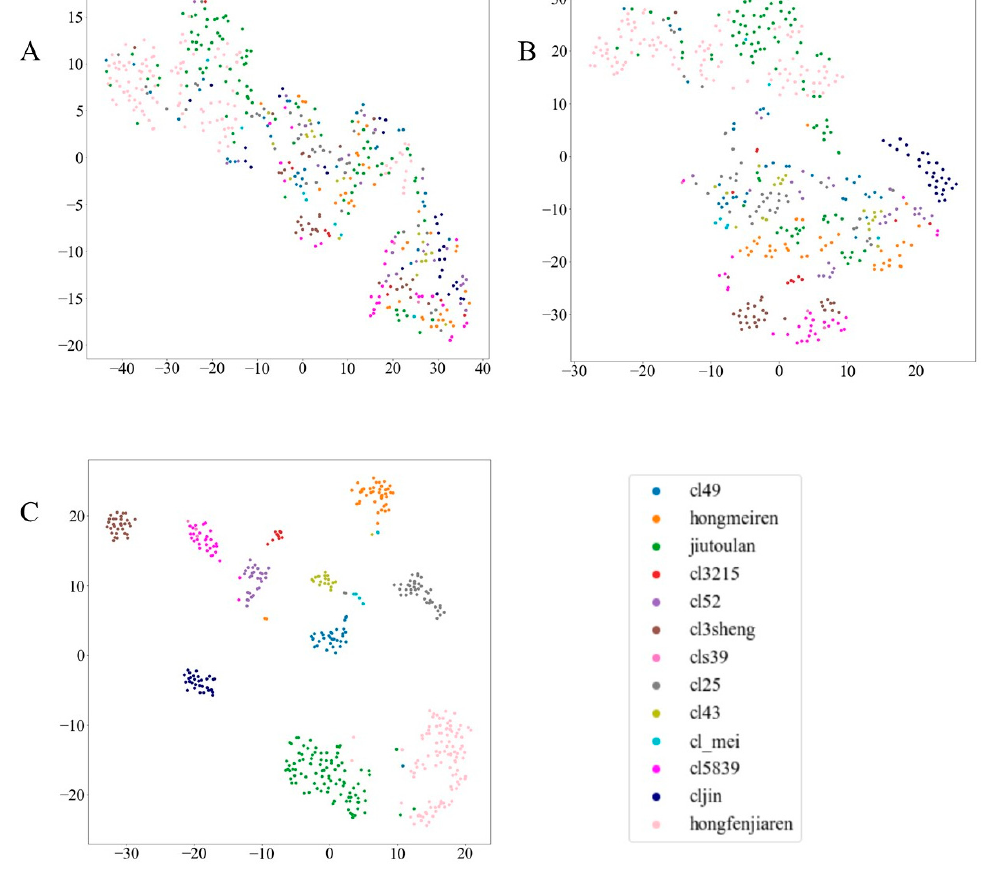
Figure 2. The visualization maps of ( A ) the raw spectral data, ( B ) the output of the stacked sparse auto-encoder (SSAE) hidden layer1 and ( C ) the output of the SSAE hidden layer2; the x–y axis of each figure corresponds to the two dimensions of the reconstructed space by t-distribution stochastic neighbor embedding (t-SNE).